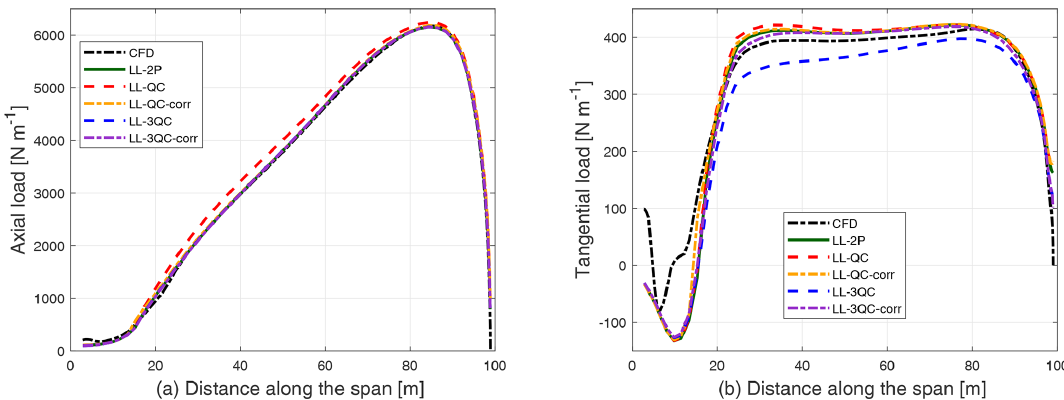
Figure 10. Comparison of axial load (a) and tangential load (b) of the straight blade with 15 ◦ of upwind coning calculated from different LL methods and the fully resolved CFD.